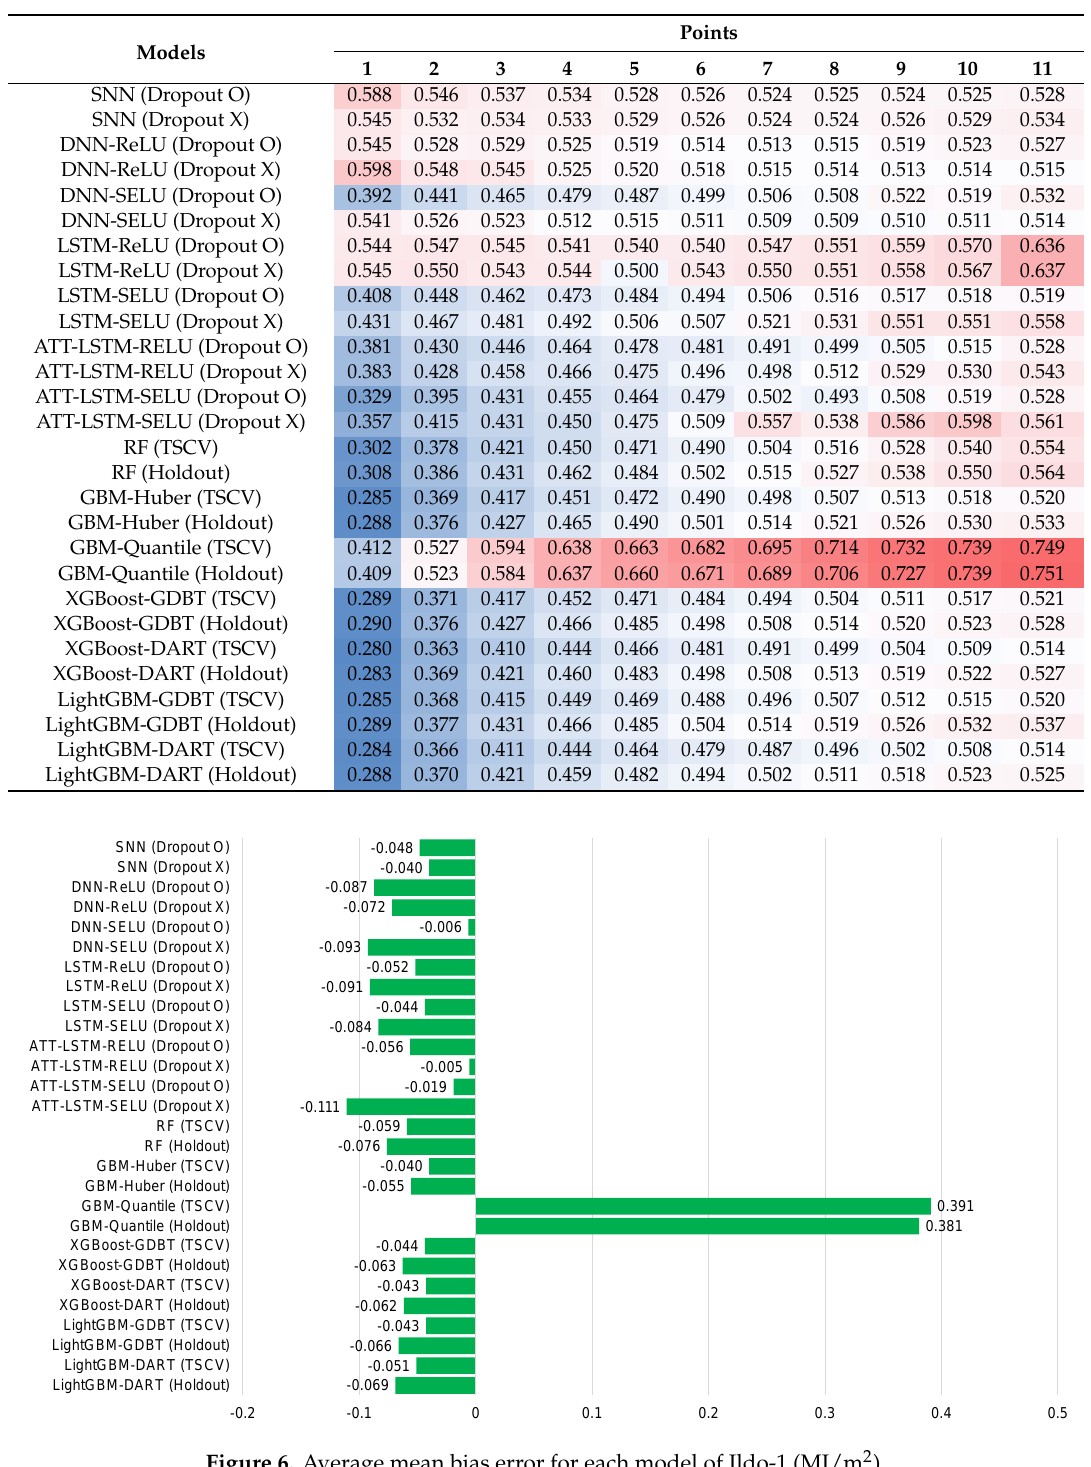
Figure 6. Average mean bias error for each model of Ildo-1 ( MJ/m ).